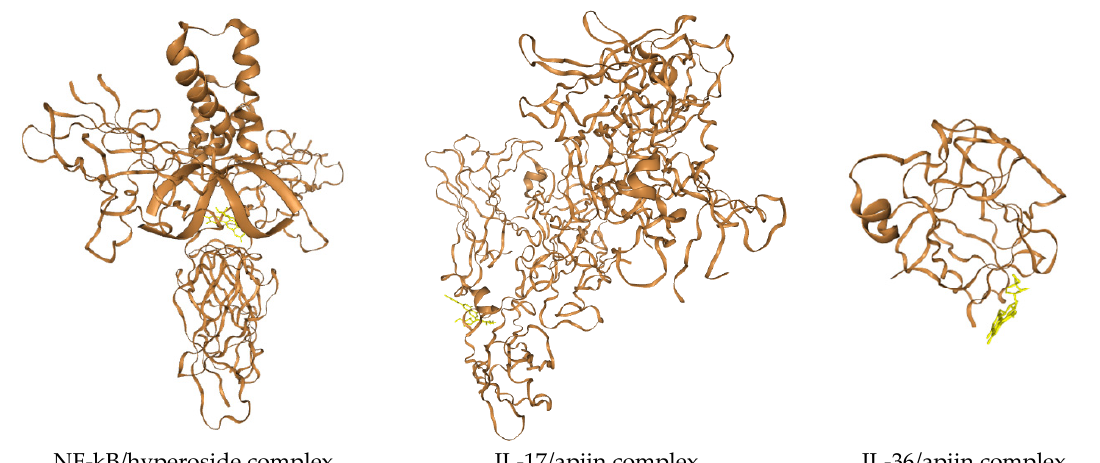
Figure 2. HDOCK scoring of complexes of the three protein targets (NF-kB, IL-17 and IL-36) involved in psoriasis investigated in our study with the plant metabolites hyperoside, guanosine, apiin and their respective reference inhibitors. Note how the scores for the top-ranked (Top-1) poses are presented in the left side of thefigure, while the means (considering the values for poses Top1– 10) with the respective Standard Deviations are shown on the right.